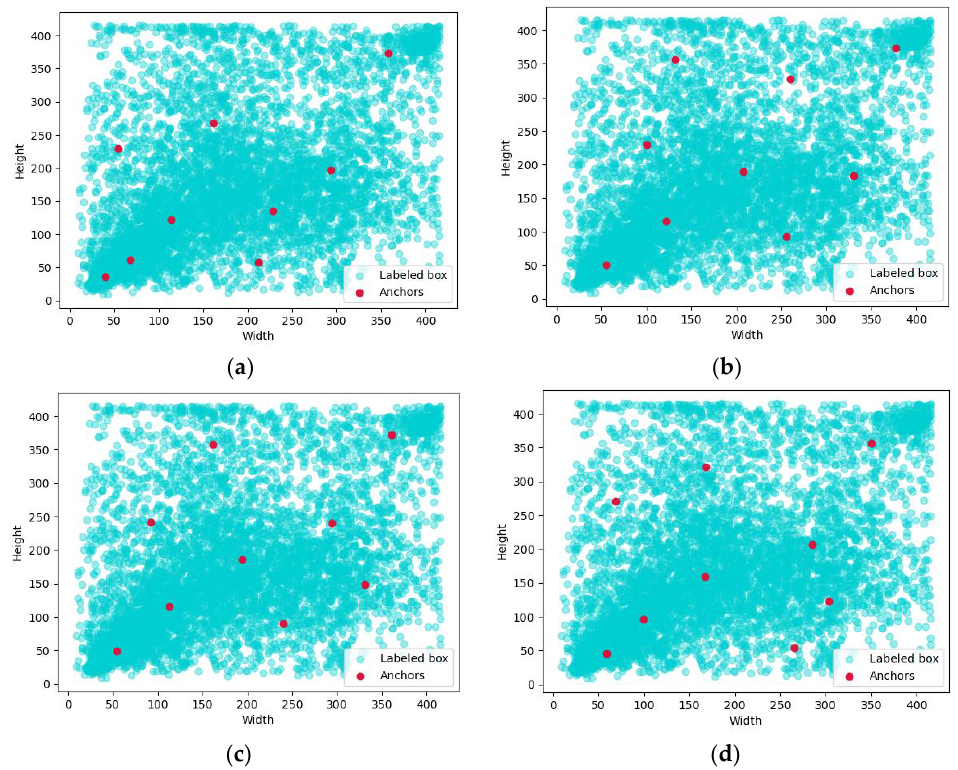
Figure 12. Clustering effect of different algorithms: ( a ) K-means algorithm with Euclidean distance; ( b ) K-means++ algorithm with Euclidean distance; ( c ) K-means algorithm with IoU; ( d ) K-means++ algorithm with IoU.